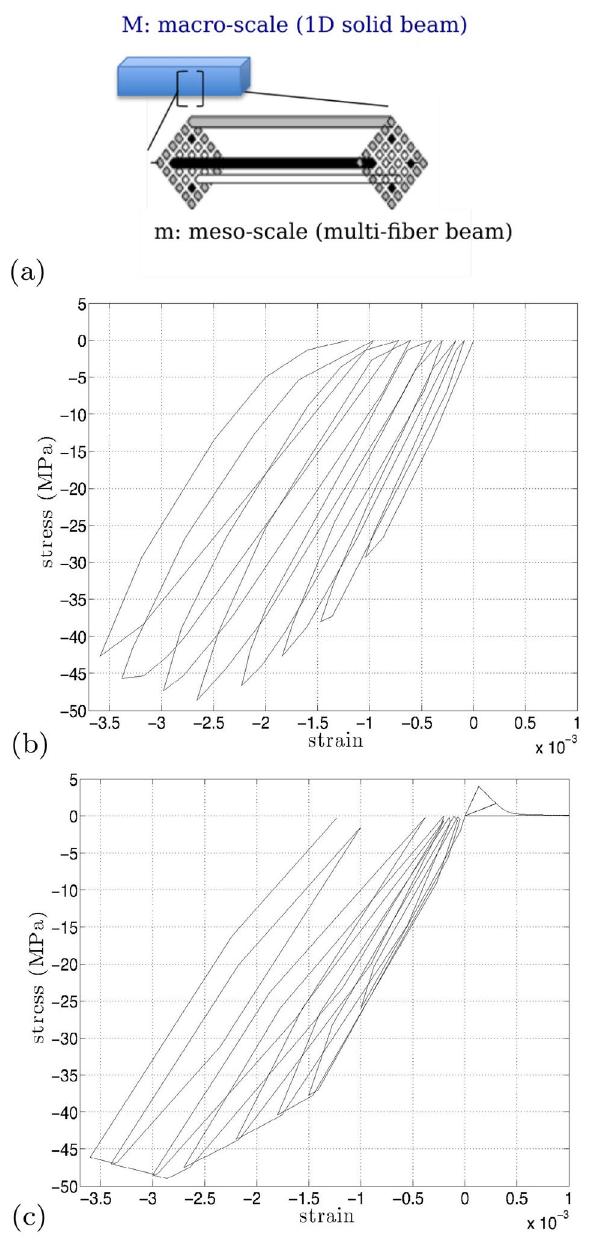
Fig. 27 Simple problem to illustrate stochastic upscaling in dynam- ical system: a Multi-scale 1D beam model; b cyclic response of con- crete in compression: Experimental stress–strain hysteresis loops [72]; c cyclic response of concrete in compression: Numerical model hysteresis loops